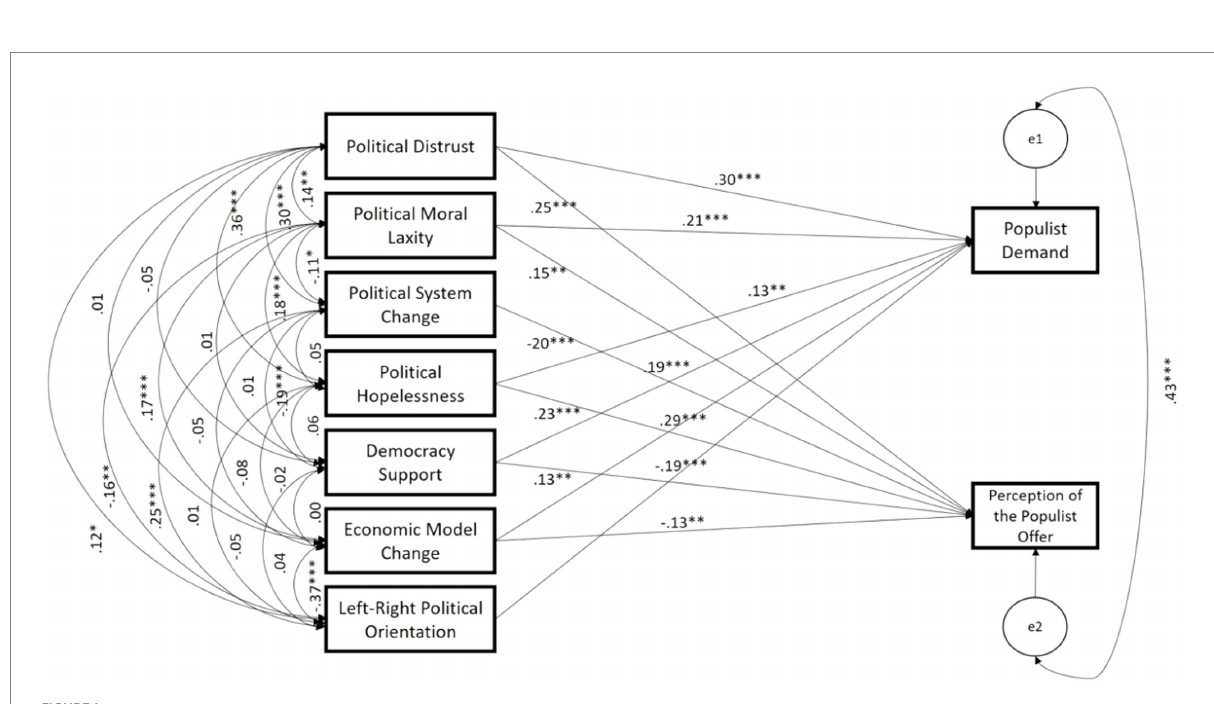
FIGURE 1 Path analysis of the proposed model. * p < 0.05; ** p < 0.01; *** p <